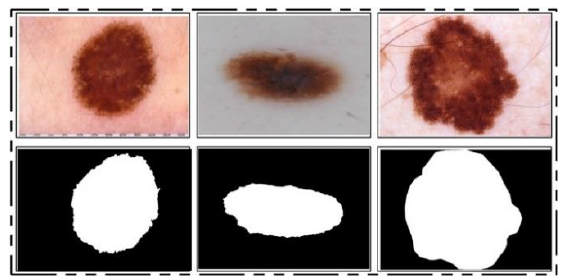
Figure 2. Sample images of the ISIC 2017 dataset.